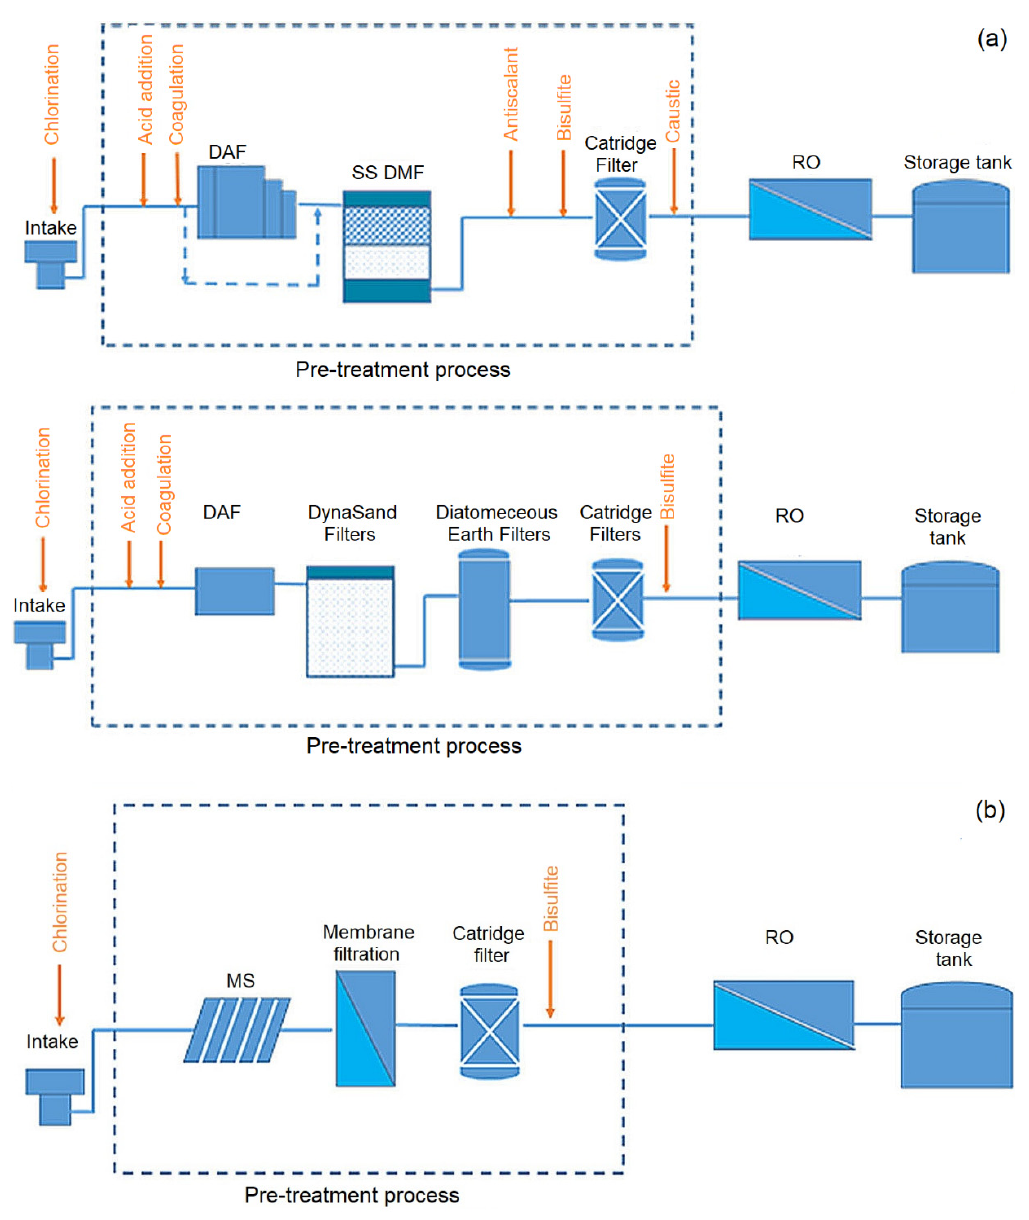
Figure 6. Pre-treatment processes: ( a ) Conventional pre-treatment process and ( b ) membrane-based pre-treatment process. Reprinted from [87] with permission from Elsevier, 2019.